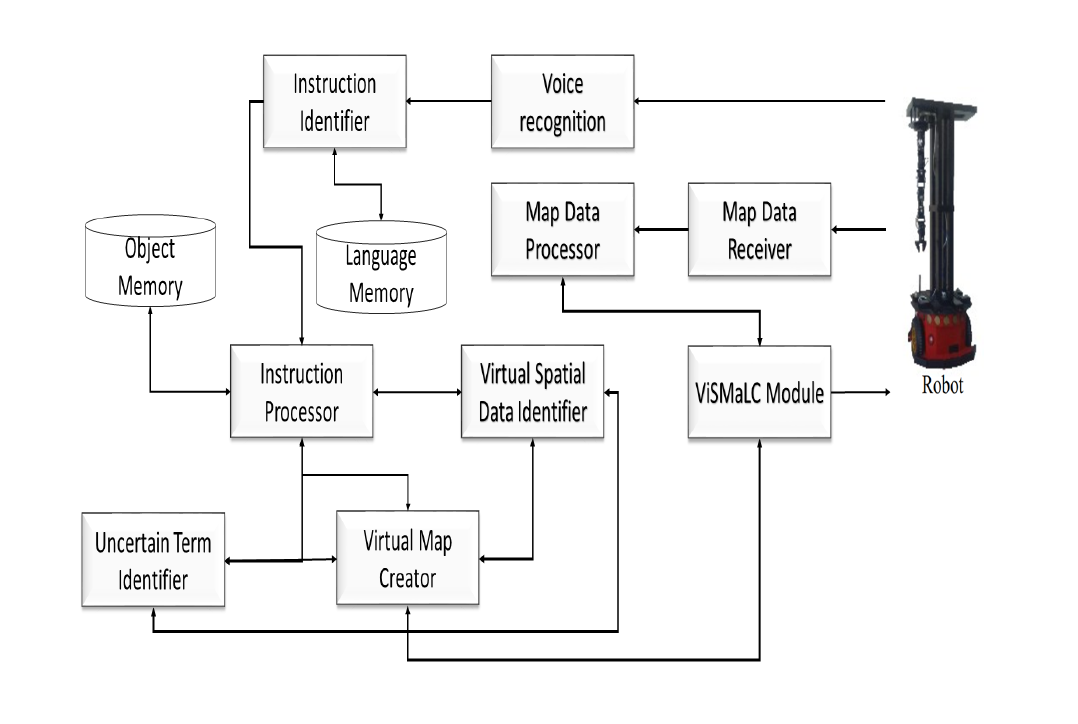
Figure 1: System overview.